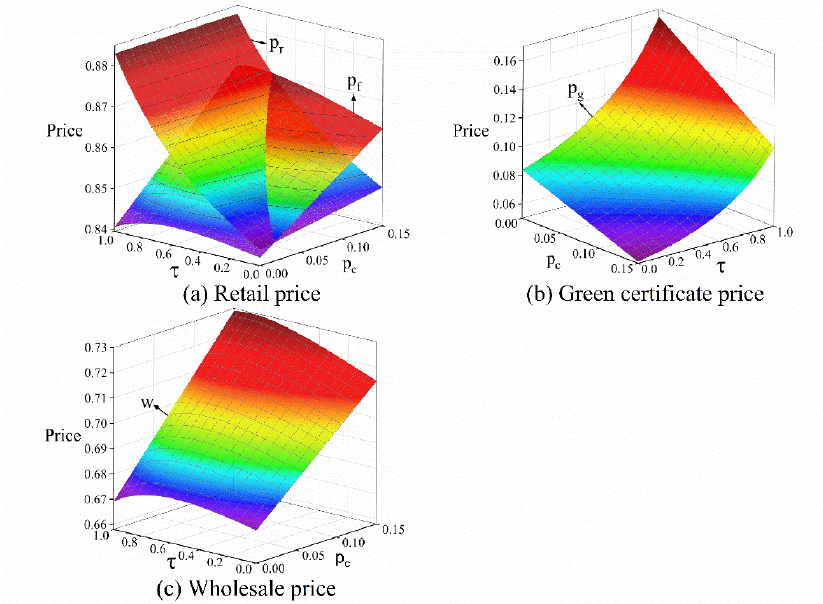
Figure 5. The trend of the price under different levels of τ and p c .